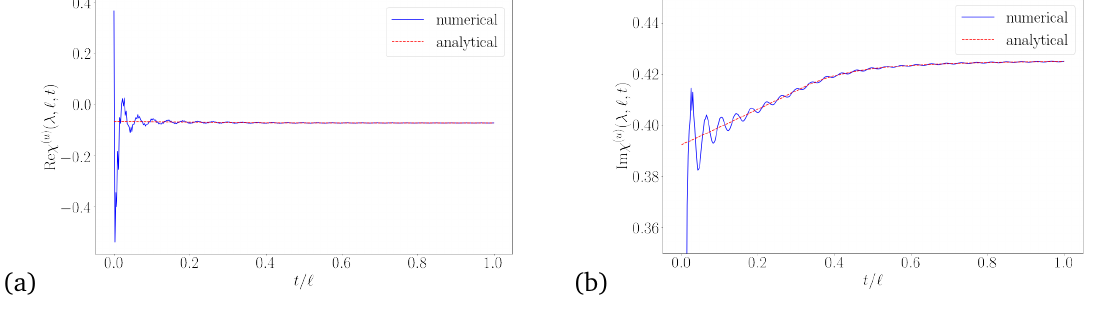
Figure 18: Real and imaginary parts of the leading approximation ( λ = 0.1, (cid:96) = 200, t ) for a transverse field quench quench from h = 0 to χ ( u ) 1 h = 0.8. The analytic approximation gives a good description only at late times.